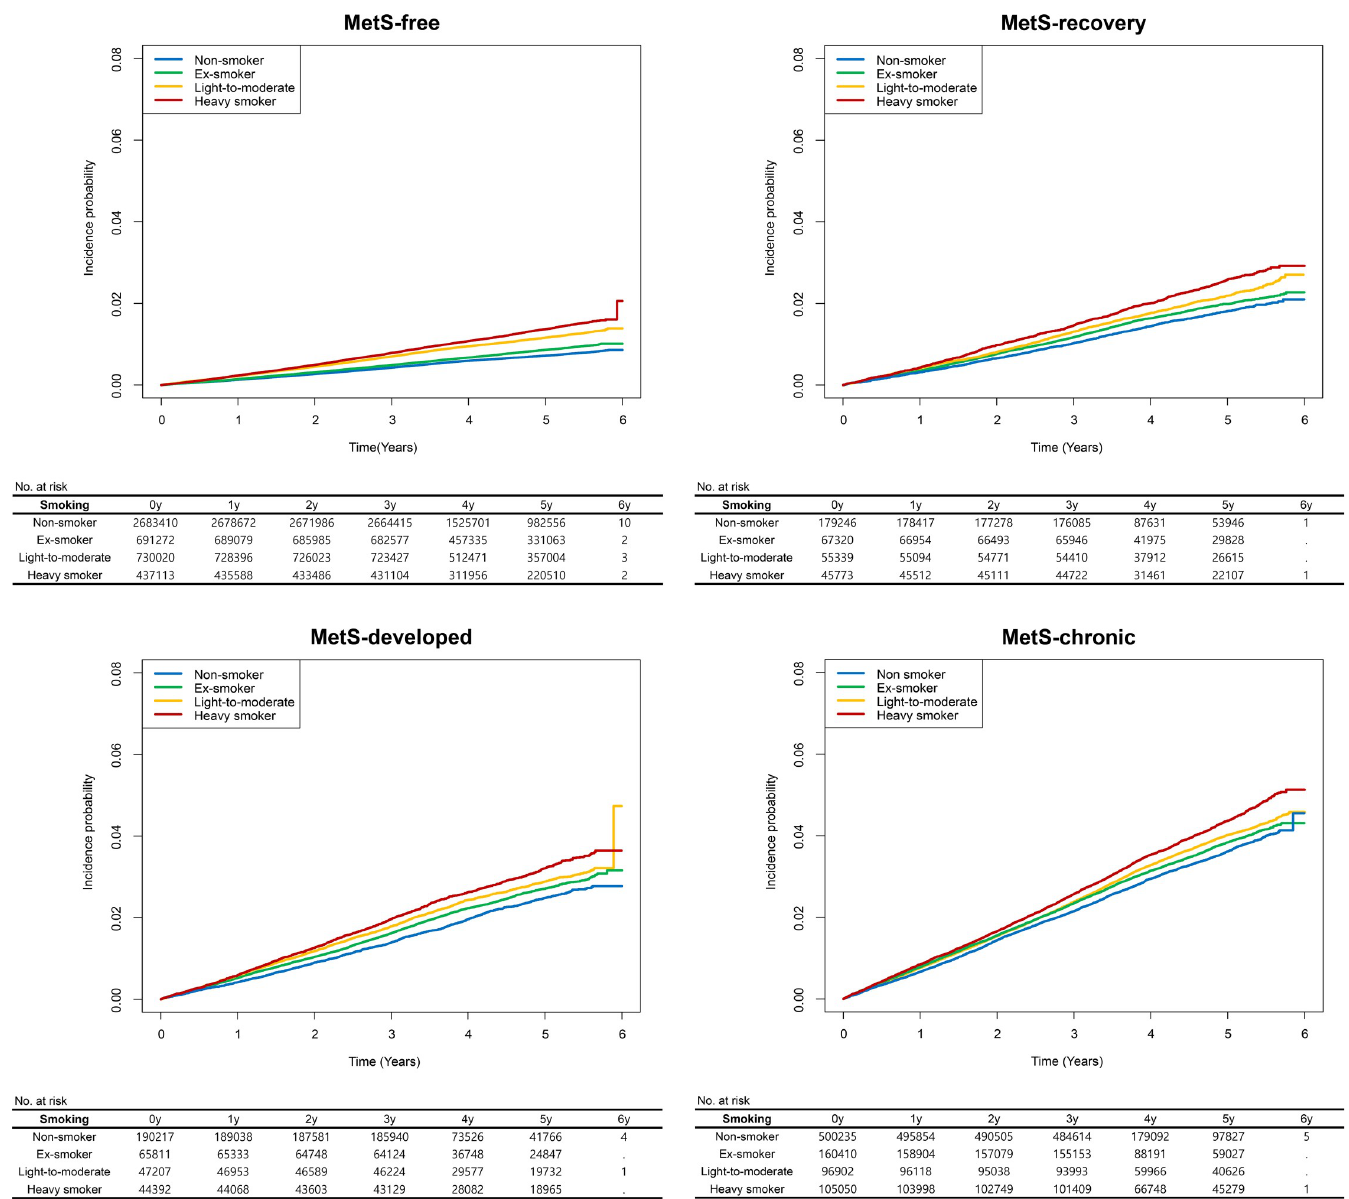
Fig 3. The survival curves were plotted in each MetS subgroup. The y-axes indicate the incidence probability of MACEs, including acute myocardial infarction, revascularization, and acute ischemic stroke. The x-axes indicate the time (years). The blue, green, orange and red curves indicate the incidences of MACEs in nonsmokers, ex-smokers, light-to-moderate smokers, and heavy smokers, respectively. The tables below the survival curves show the numbers of persons at risk. MetS = metabolic